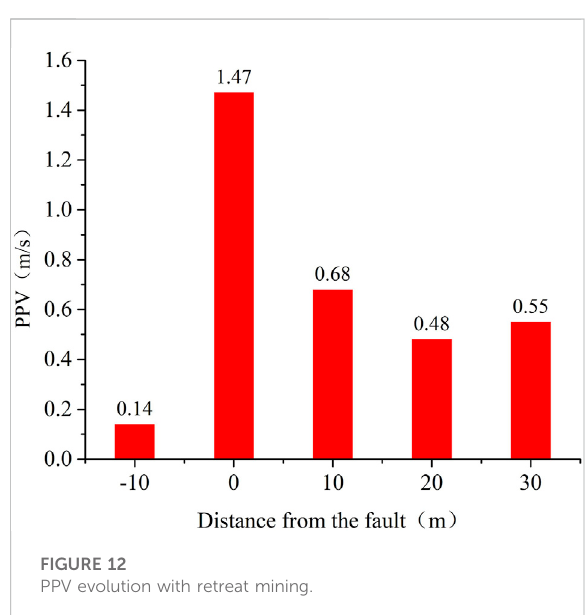
FIGURE 12 PPV evolution with retreat